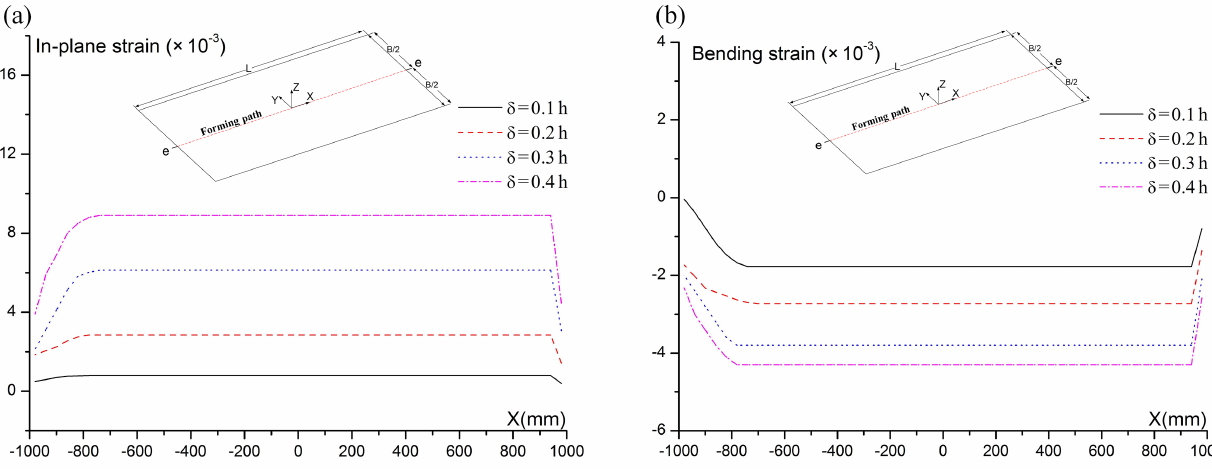
Figure 7. Relationship between press amount and midline strain variation of the rolling line of pressed plate. (a) In-plane strain distribution. (b) Bending strain